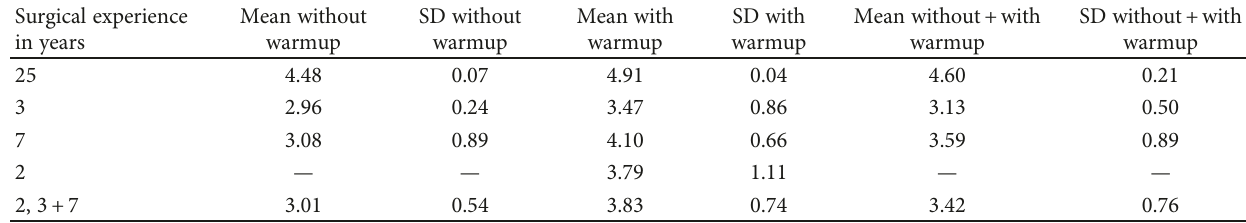
Table 3: Performance scatter depending on surgical